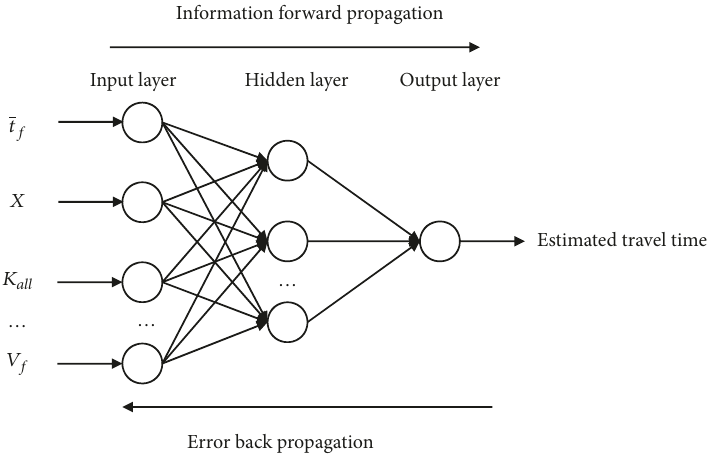
Figure 6: The network structure of the three-layer BP neural network model.